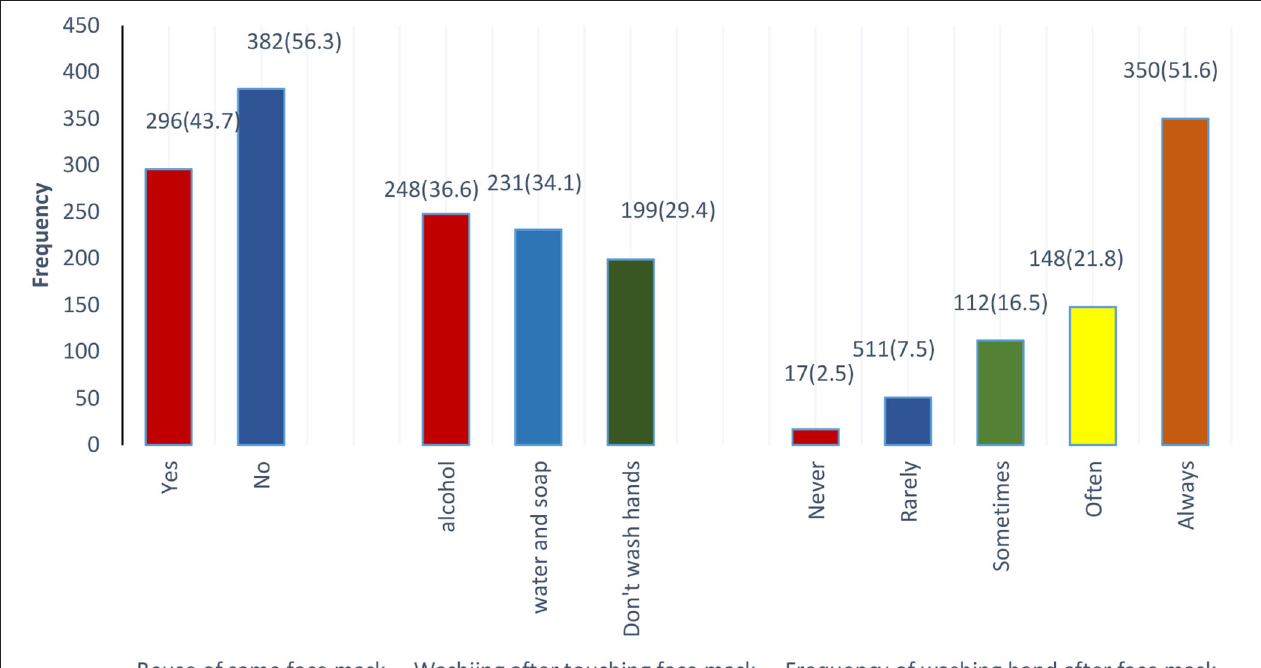
FIGURE 3 | Participant’s practice using a face